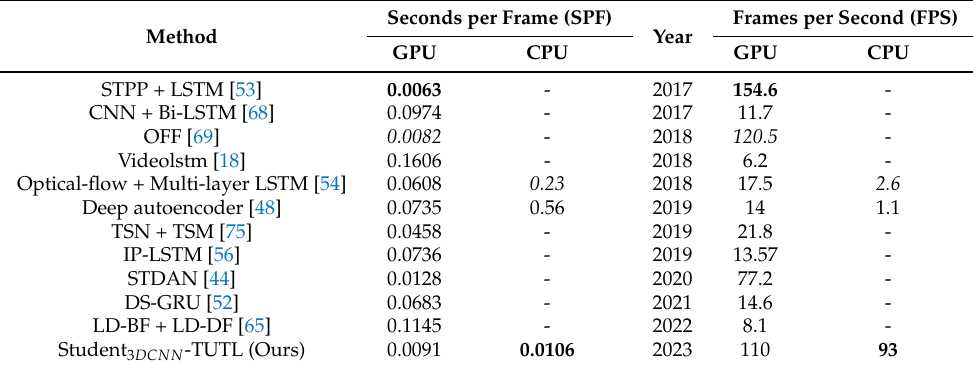
Table 16. Run time analysis of our proposed framework with the state-of-the-art human action recognition methods (with